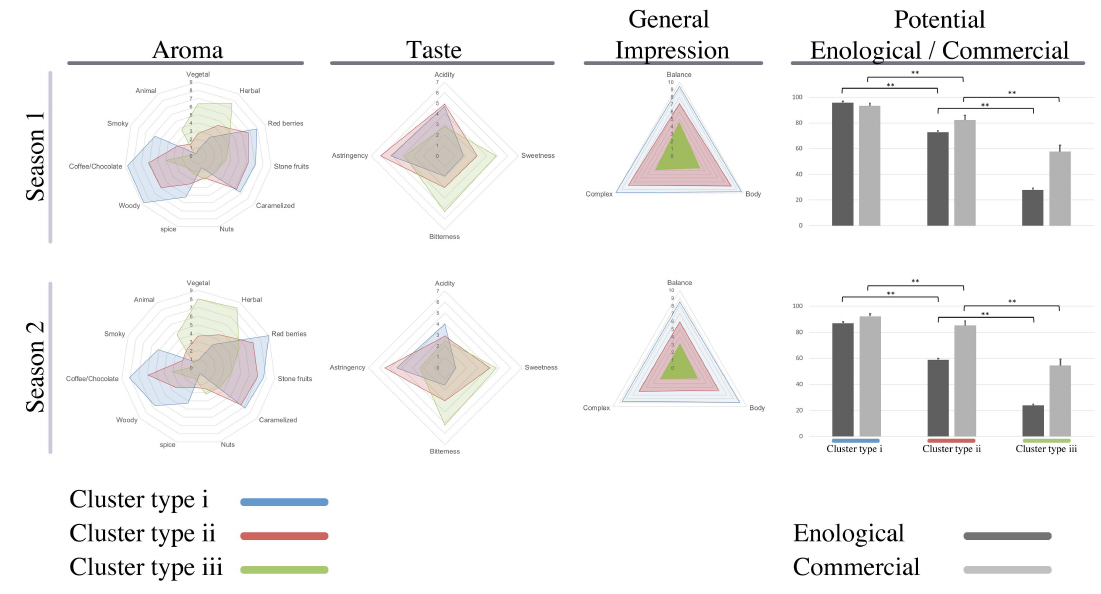
Figure 2. Sensory analysis. Graph of the mean sensory ratings of the three Pinot noir wines studied. Ten experienced Pinot noir wine-makers conducted Duo-Trio test trials to determine the overall di ff erence between wines